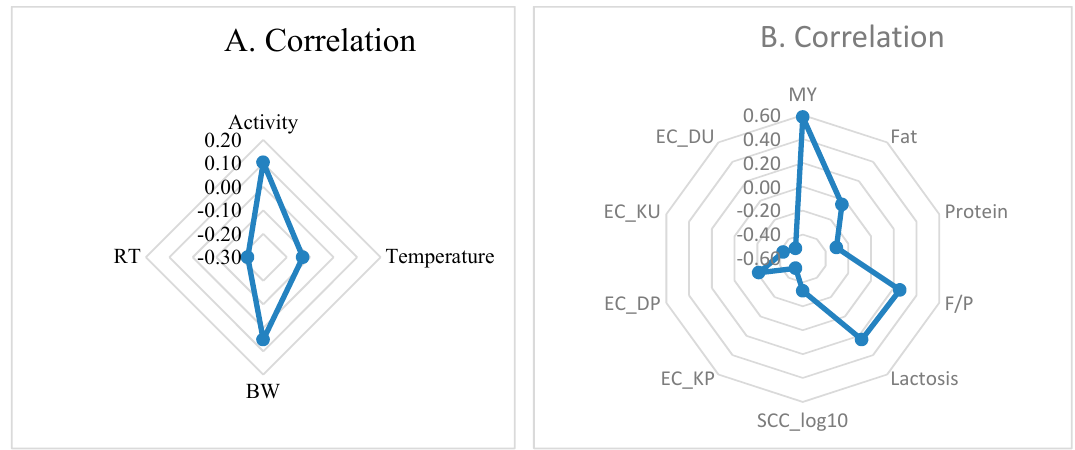
Figure 4. ( A , B ). Reticulorumen pH correlations with indicators from AMS. RT—rumination time; BW—body weight; SCC—somatic cell count; EC—electrical conductivity of milk at the udder quarter level (DU—rear right, KU—rear left, DP—front right, KP—front left). Reticulorumen temperature and RT were weakly negatively related with reticulorumen pH (r =